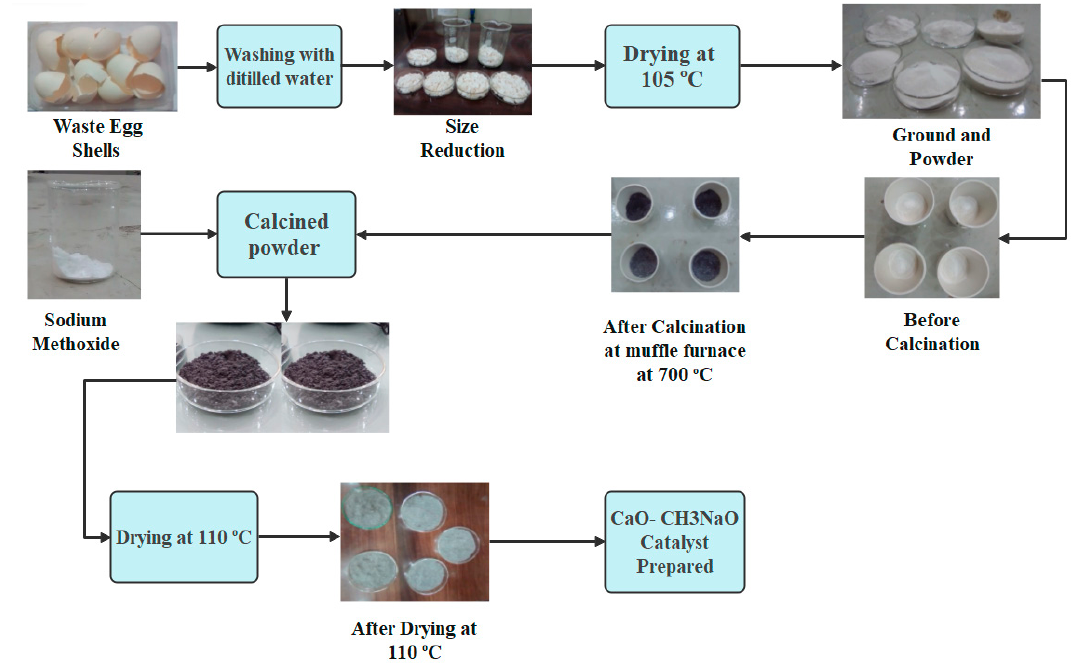
Figure 10. Steps involved in complete synthesis of CH 3 NaO-doped CaO catalyst.